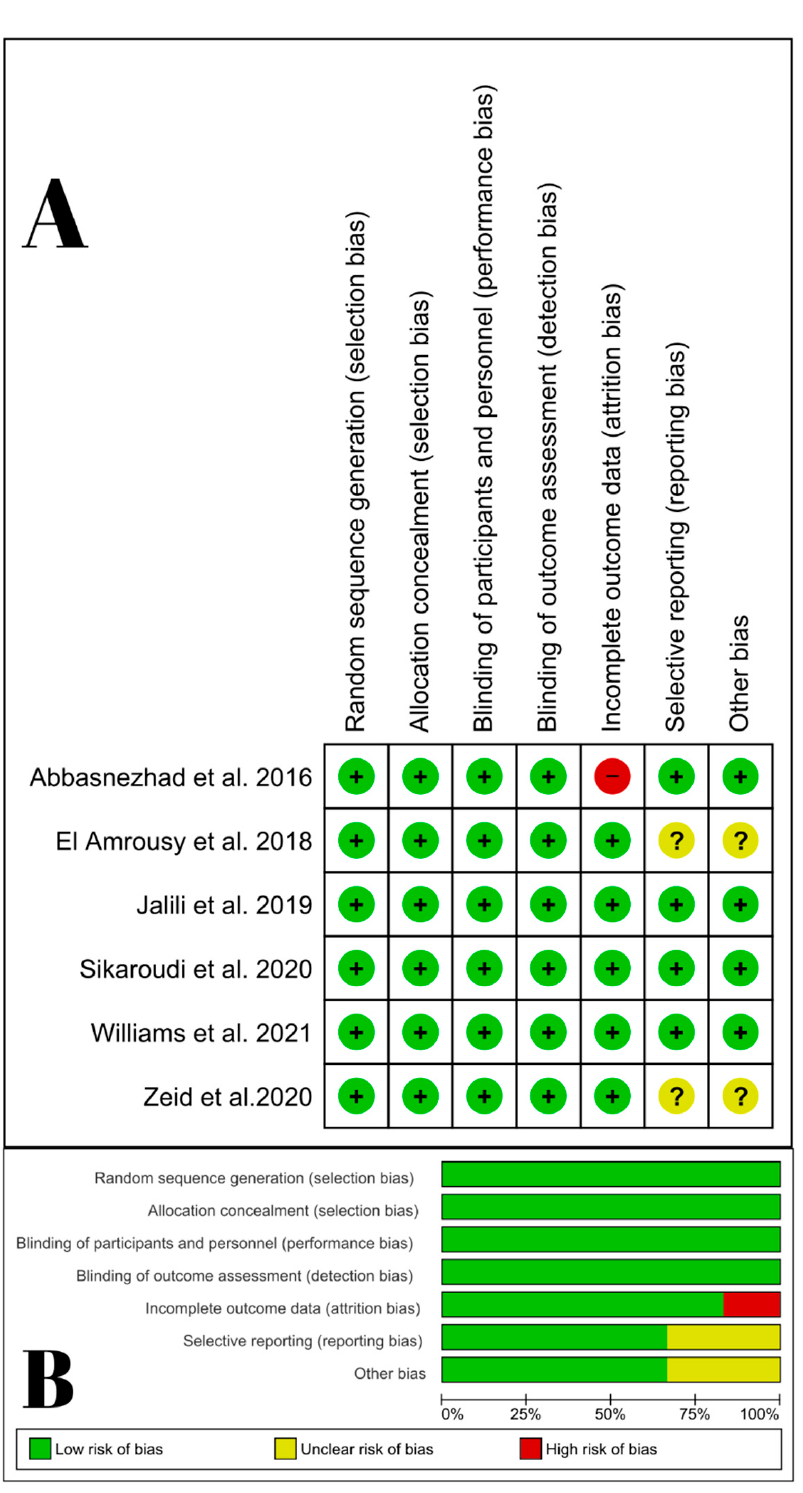
Figure 2. Quality assessment of risk of bias in the studies in the meta-analysis. ( A ) The upper panel presents a schematic representation of risks (low = red, unclear = yellow, and high = red) for specific types of biases of each of the studies in the review [27–32]. ( B ) The lower panel presents risks (low = red, unclear = yellow, and high = red) for the sub-types of biases of the combination of studies included in this review [43].